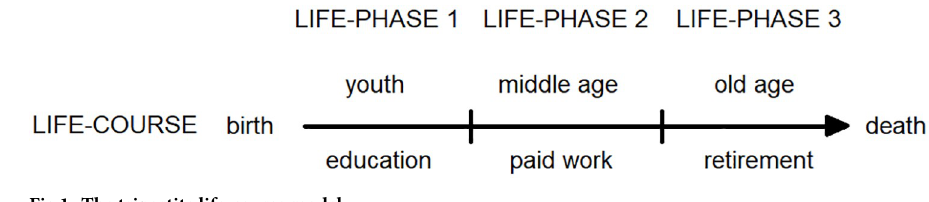
Fig 1. The tripartite life-course